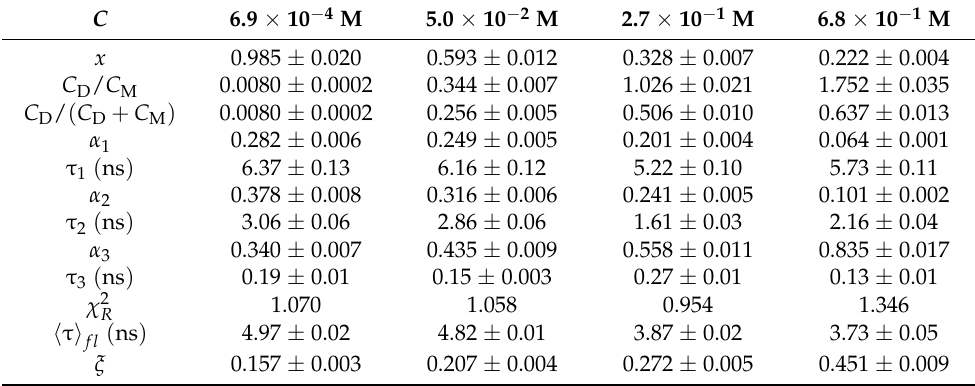
Table 1. The parameters of FMN fluorescence decay in PVA films (rigid solutions) fitted to the sum of three exponentials and the values of mean FMN fluorescence lifetimes obtained from Equation (9) at λ exc = 445 nm and λ obs = 530 nm, at T = 293 K. The parameters were estimated from the best fit with the data, with calculated standard deviations. ξ —parameter of the degree of nonexponentiality of the decay calculated from Equation (10), and x —is the fraction of molecules appearing in monomer form calculated from Equation